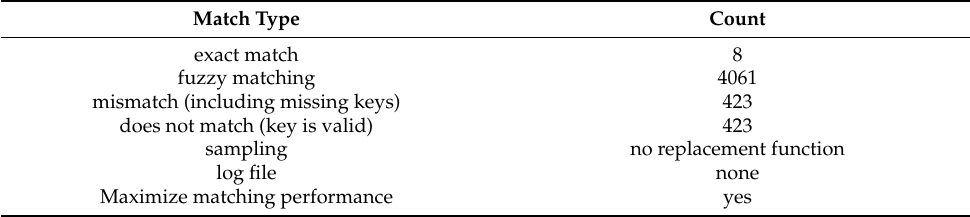
Table 6. Case Control Match